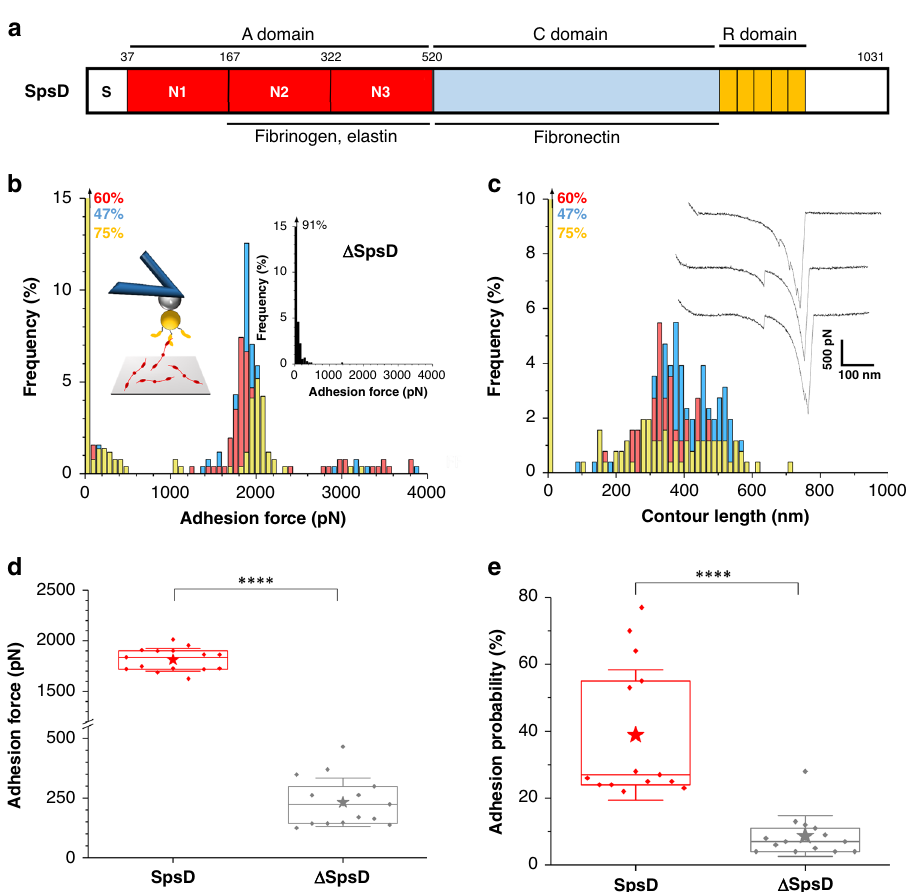
Fig. 1 SpsD mediates strong bacterial adhesion to fi brinogen-surfaces. ( a ) Schematic representation of the SpsD protein from S. pseudintermedius ED99. Following a signal sequence (S), SpsD exhibits an A domain, homologous to FnBPs and Clfs from S. aureus , a connecting region C and a repeat region R. Maximum adhesion force ( b ) and contour length ( c ) histograms obtained by recording force – distance curves in PBS between three different S. pseudintermedius ED99 SpsD cells and Fg-coated surfaces, at a retraction velocity of 1000 nm s − 1 (total number of curves from 3 cells n = 207). Insets in ( b ) show a scheme of the setup and the adhesion force histogram obtained on Δ SpsD cells (3 cells merged). Inset in ( c ) shows representative retraction force pro fi les for SpsD cells. Box plots of the mean adhesion forces ( d ) and the mean adhesion probabilities ( e ) observed for 15 cells from 5 independent cultures. Mean adhesion forces were estimated from the sharp peaks (range of 1100 – 2300 pN) shown in ( c ). Stars are the mean values, lines the medians, boxes the 25 – 75% quartiles and whiskers the SD. Student t -test: **** p ≤